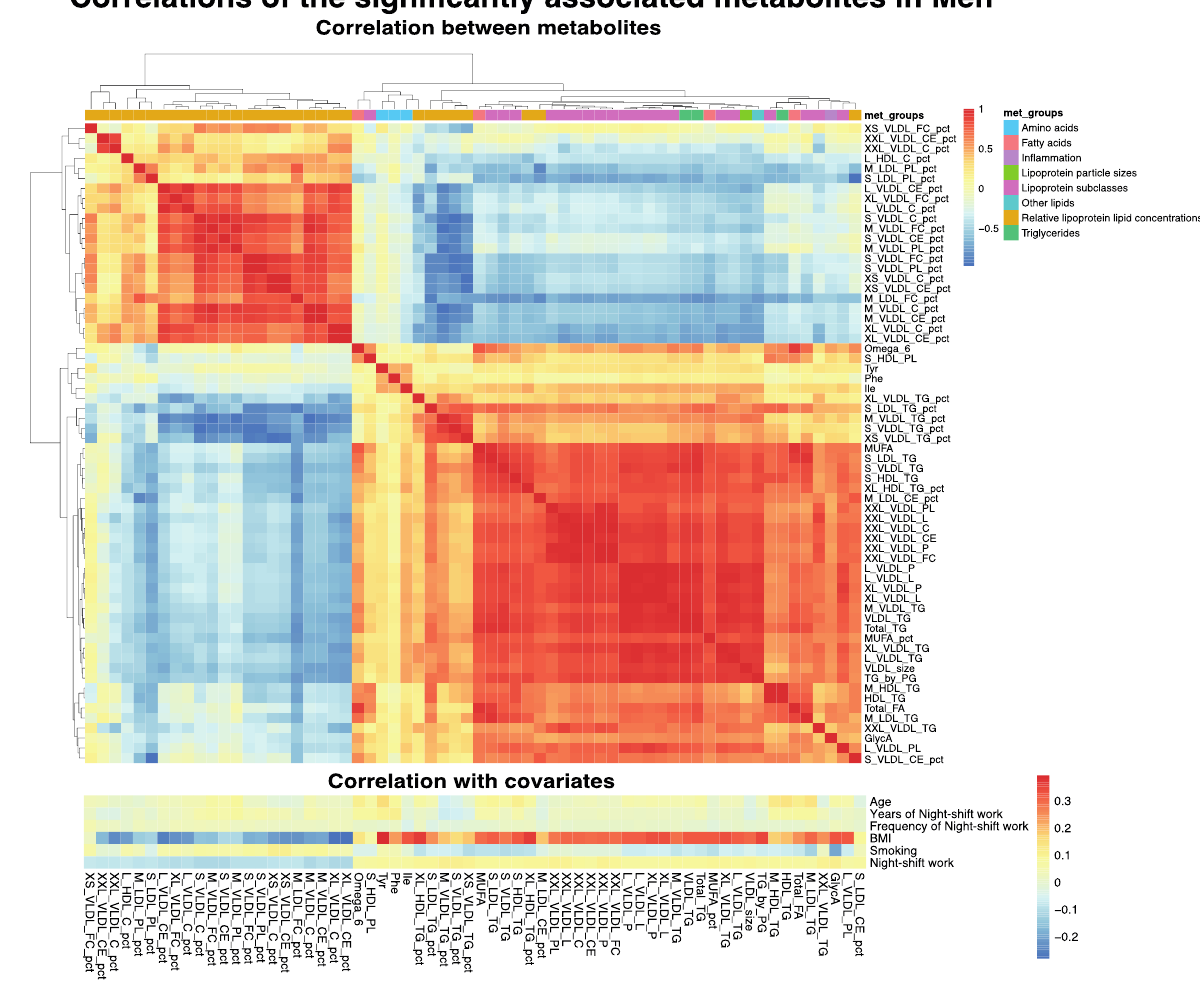
Figure 3. Correlations of the metabolite markers in males that were significantly associated with night shift work, including correlation with covariates.